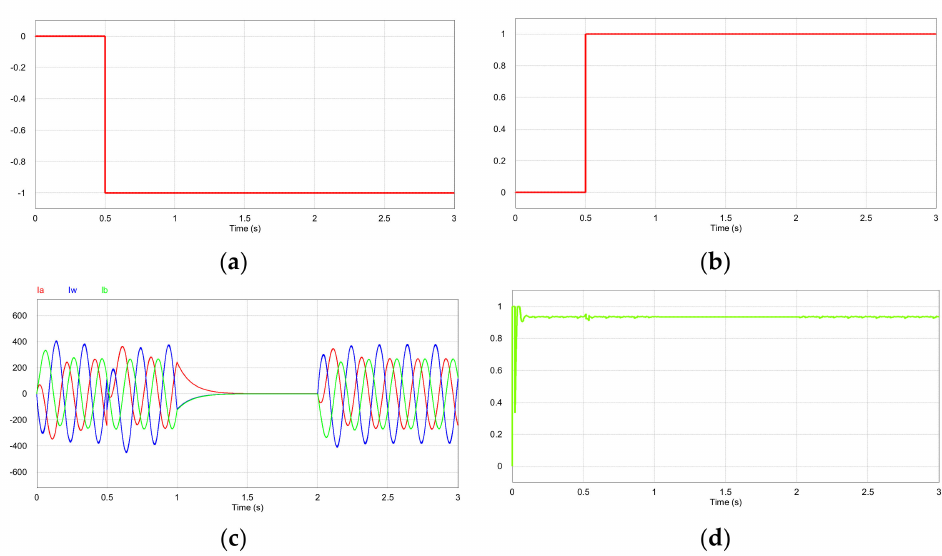
Figure 11. Faulty V 1 and V 2 at t = 0.5 s. ( a ) faulty signal of V 1 ; ( b ) faulty signal of V 2 ; ( c ) Output currents; ( d ) power factor.